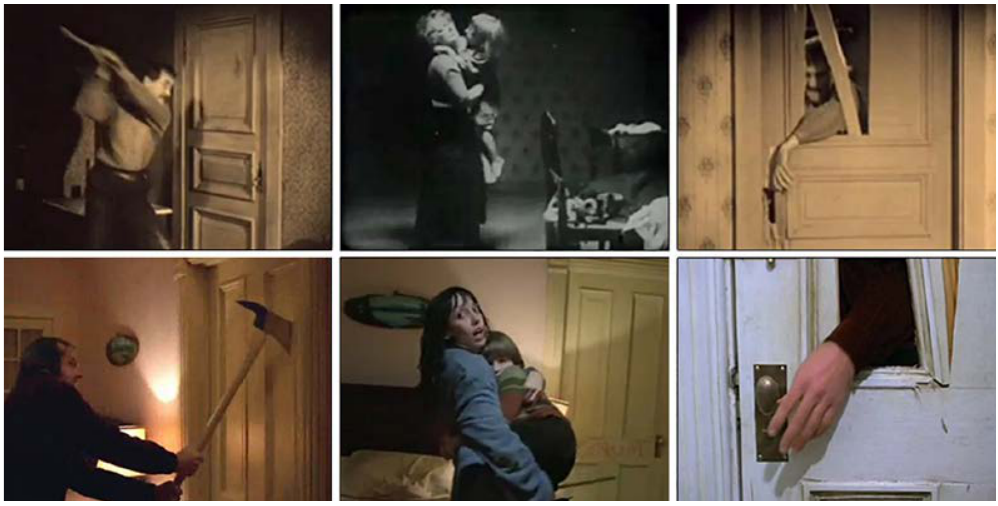
Fig. 12 Victor Sjöström, The Phantom Carriage , 1921 (above); Stanley Kubrick, The Shining , 1980